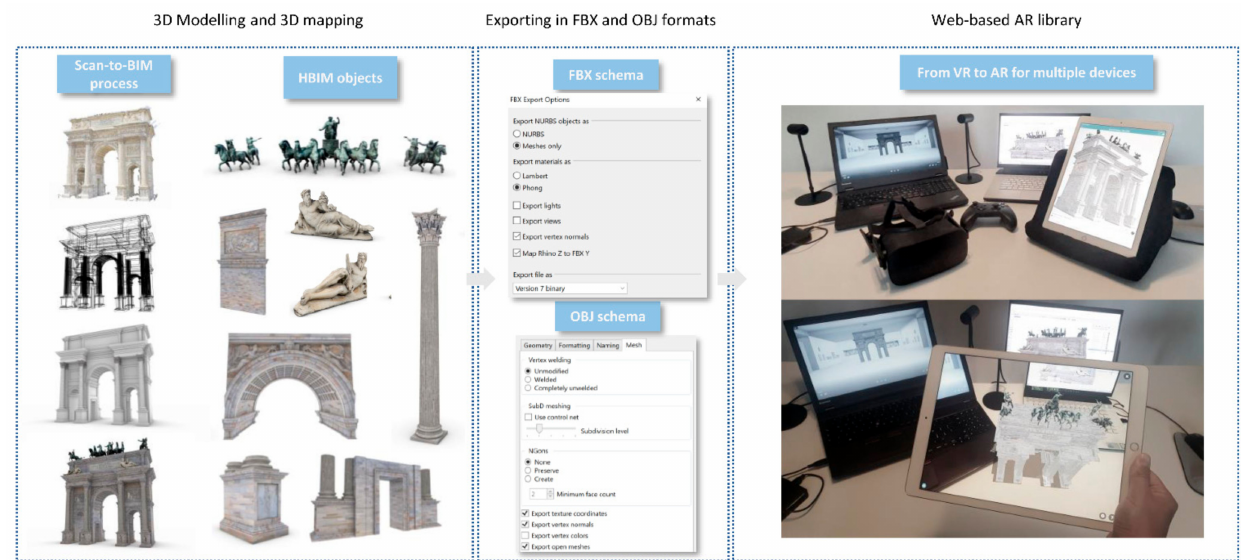
Figure 18. Web-based AR platform: from interactive virtual objects (IVOs) to AR